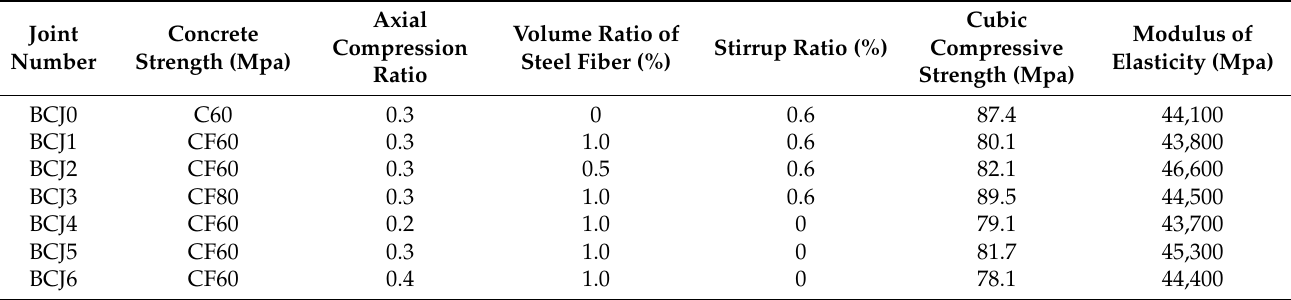
Table 1. Detail parameters of the test